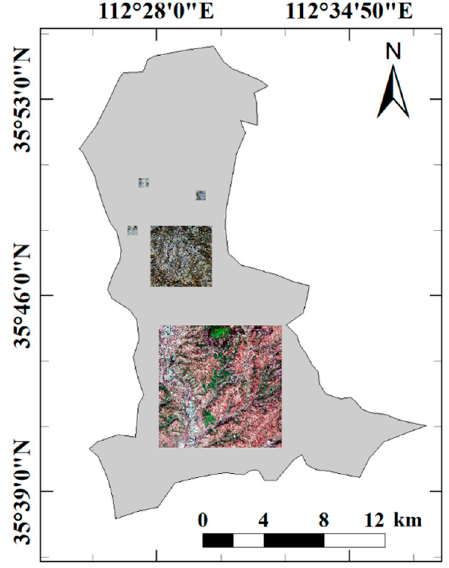
Figure 6. Range and distribution of the WorldView-1 and GF-2 images after fusion, and the geographic spacing of the GF-2 test area and sample area. The largest image in the figure is the fused WorldView-1 sample area. The medium image in the figure is the fused GF-2 sample area. The three smallest images in the figure are the fused GF-2 test area images.